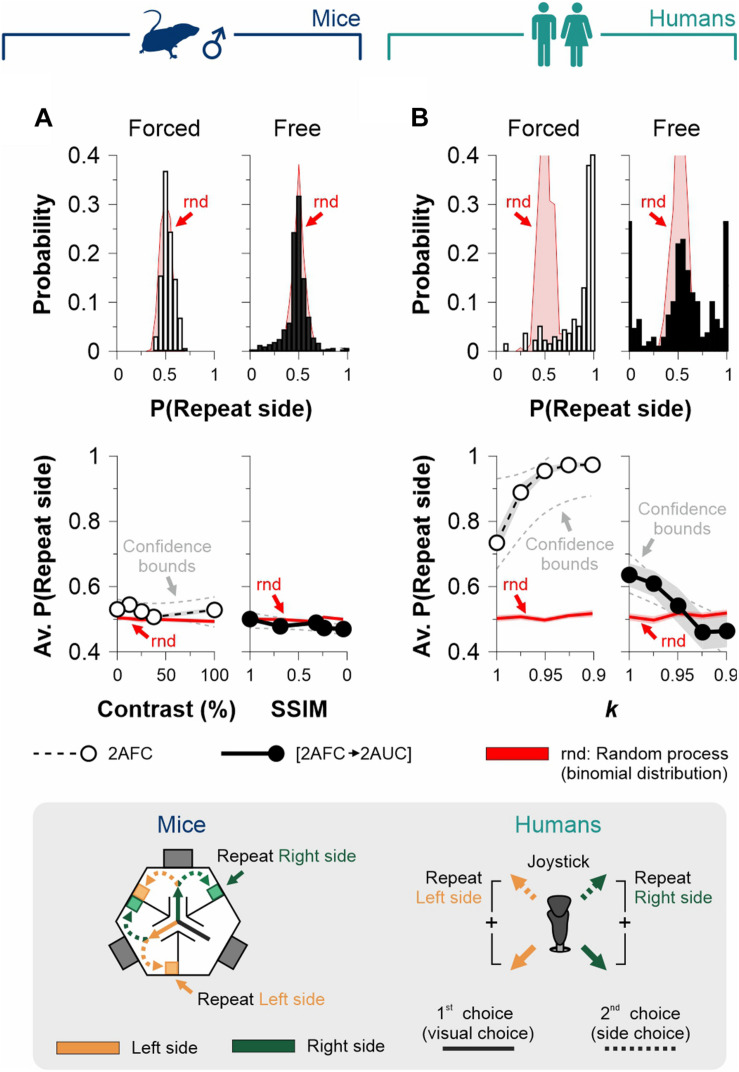
Assessment of sequential effects in the 2AFC and [2AFC→ 2AUC] tasks for mice and humans. We calculated and extracted the probabilities that side-choices involved the same side as the previous visual choice during each trial (P[repeat side]) for the 2AFC tasks (empty bars and circles) and the [2AFC→ 2AUC] tasks (filled bars and circles) for male mice (A) and human participants (B). Upper panels show the probability distributions, whereas the lower panels show the average probabilities as a function of stimulus discriminability. Red distributions and traces correspond to a random process derived from a binomial distribution involving the same number of observed trials. Note how, for mouse tasks, the P(repeat side) were similar to chance distributions. This implies that arm selection and side choice were fully independent processes. In contrast, in the human tasks, the P(repeat side) shows considerable differences against chance distributions (upper panels), which is also reflected as a dependence of P(repeat side) on stimulus discriminability (lower panels).